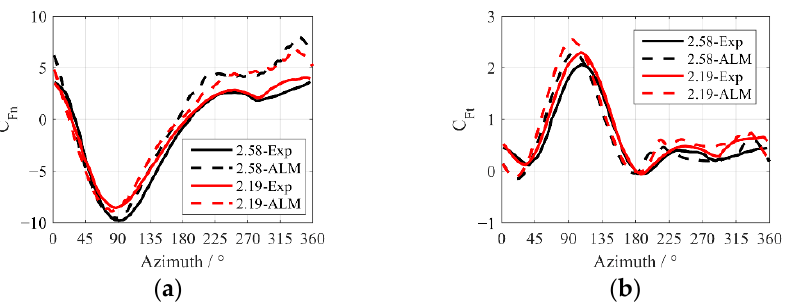
Figure 5. Comparison of simulated instantaneous force coefficients against experimental data [36] : ( a ) normal and ( b ) tangential.